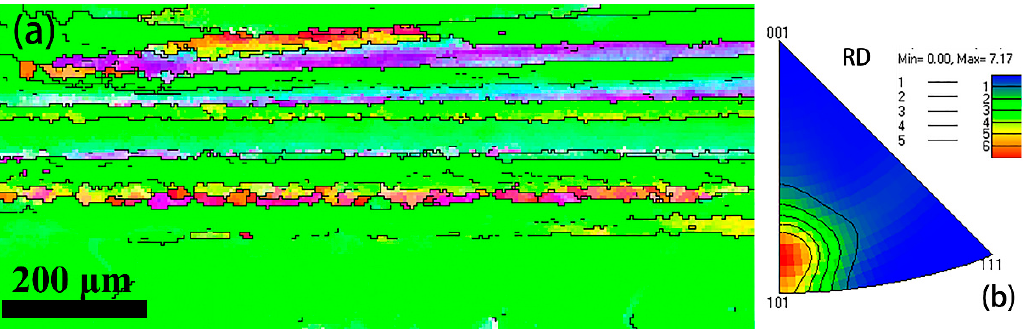
Figure 7. Microstructures of samples after tensile deformation. ( a ) EBSD orientation map at 350 °C; ( b ) inverse pole figure.